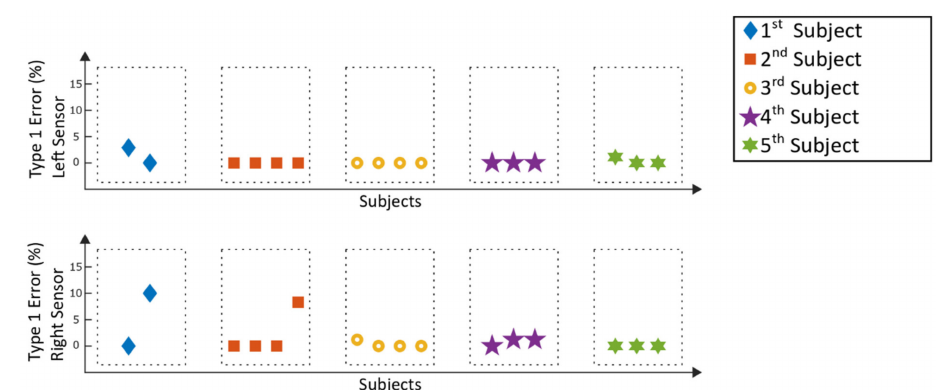
Figure 11. Lokomat measurements: detection rates of the selection windows.